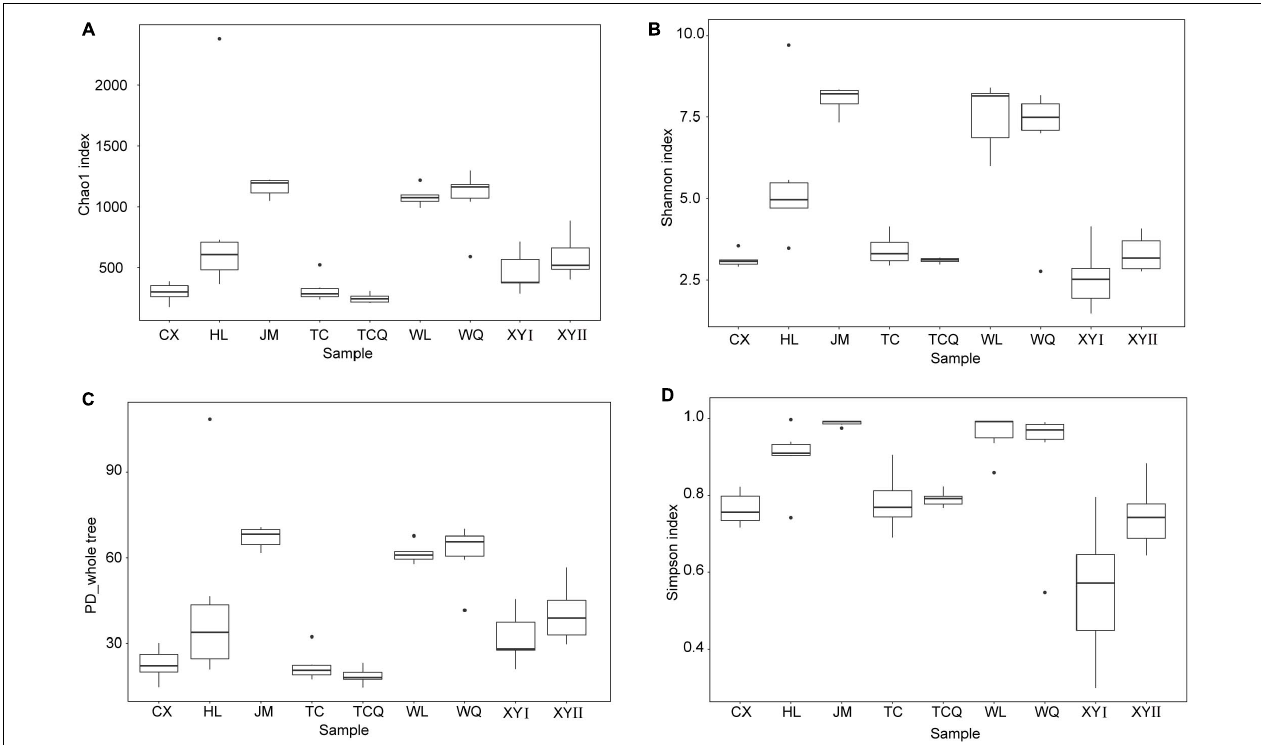
FIGURE 4 | Alpha diversity indices of bacterial communities of CPB from different sampling sites. (A) Chao1 index. (B) Shannon index. (C) PD whole tree. (D) Simpson index.